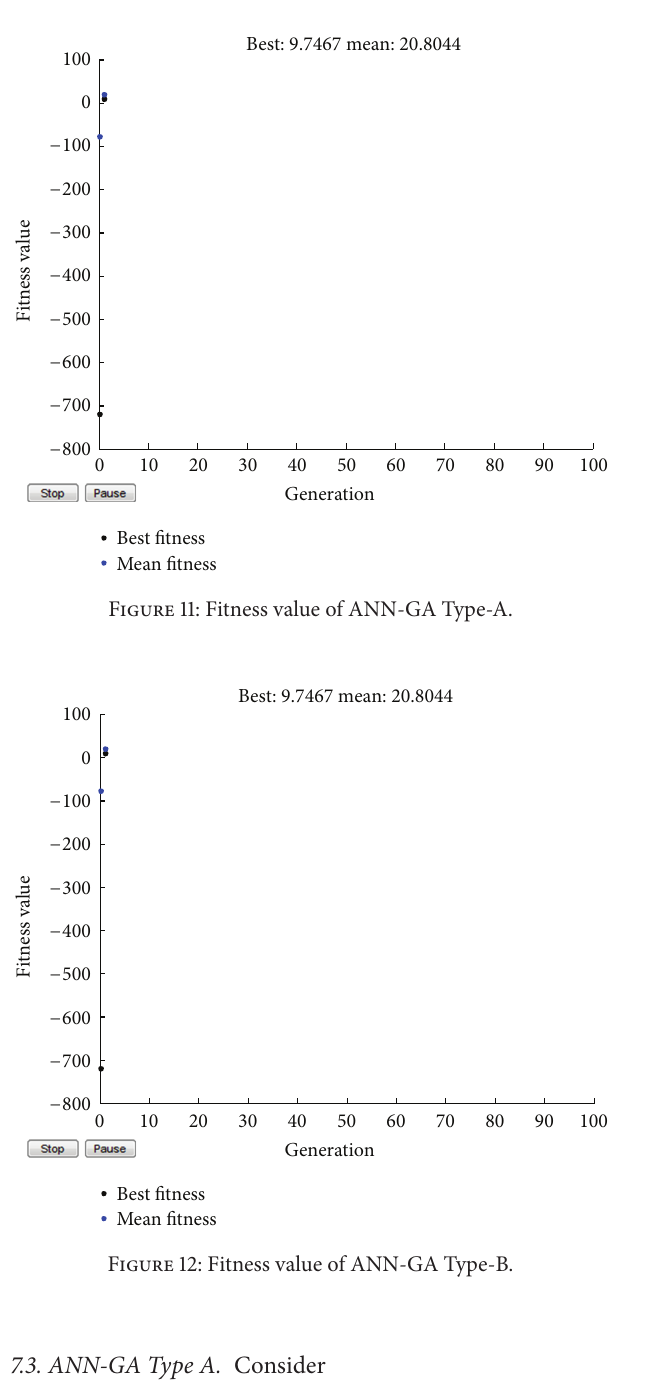
Figure 12: Fitness value of ANN-GA